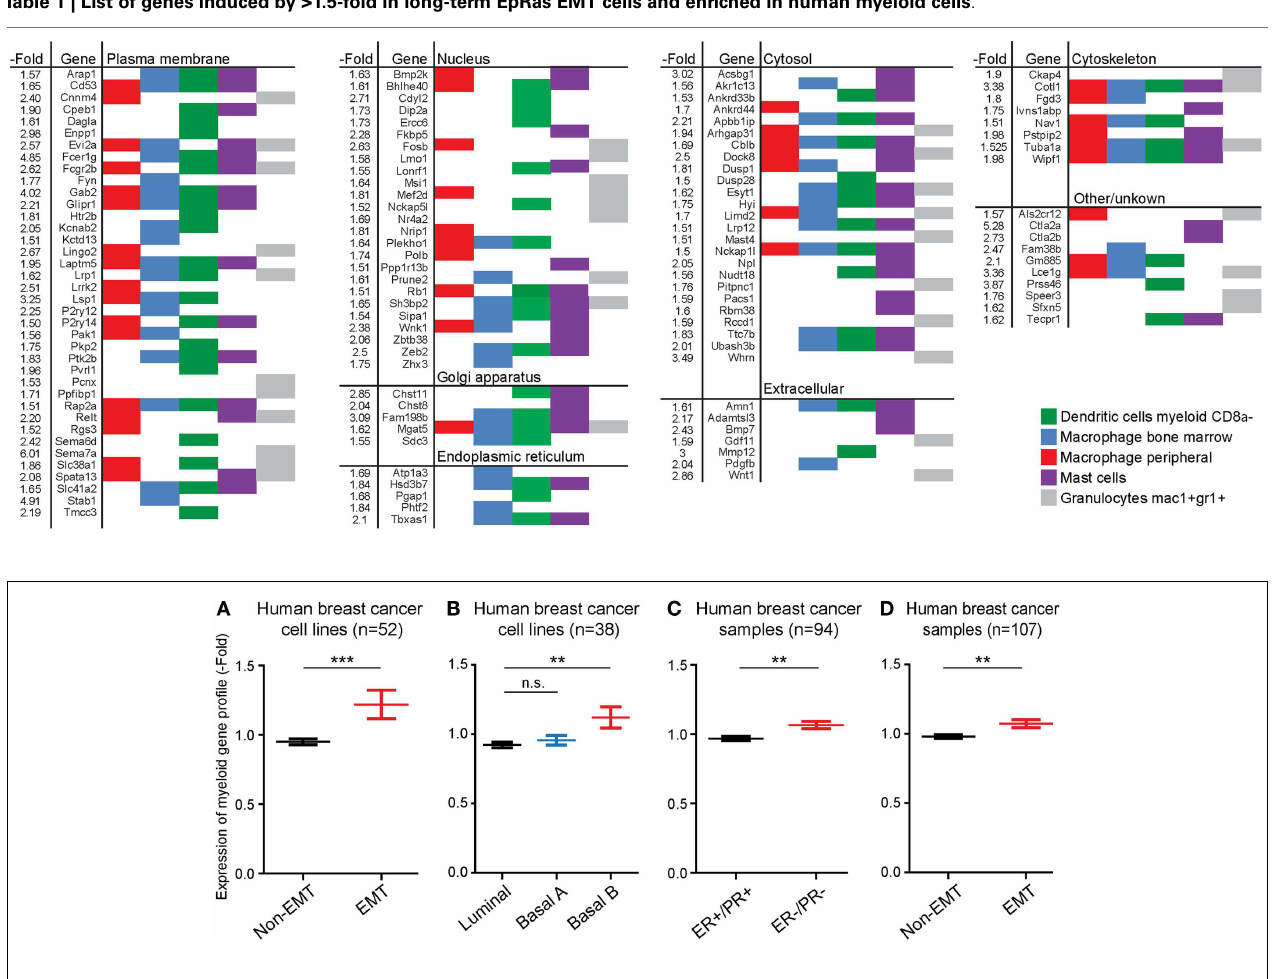
(C,D) Bar graphs showing that the average expression level of the EMT-induced monocyte/macrophage cluster was increased in human breast cancer samples negative for estrogen and progesterone receptors (ER − /PR − ) compared to ER + /PR + tumors, and in tumors displaying EMT vs. non-EMT